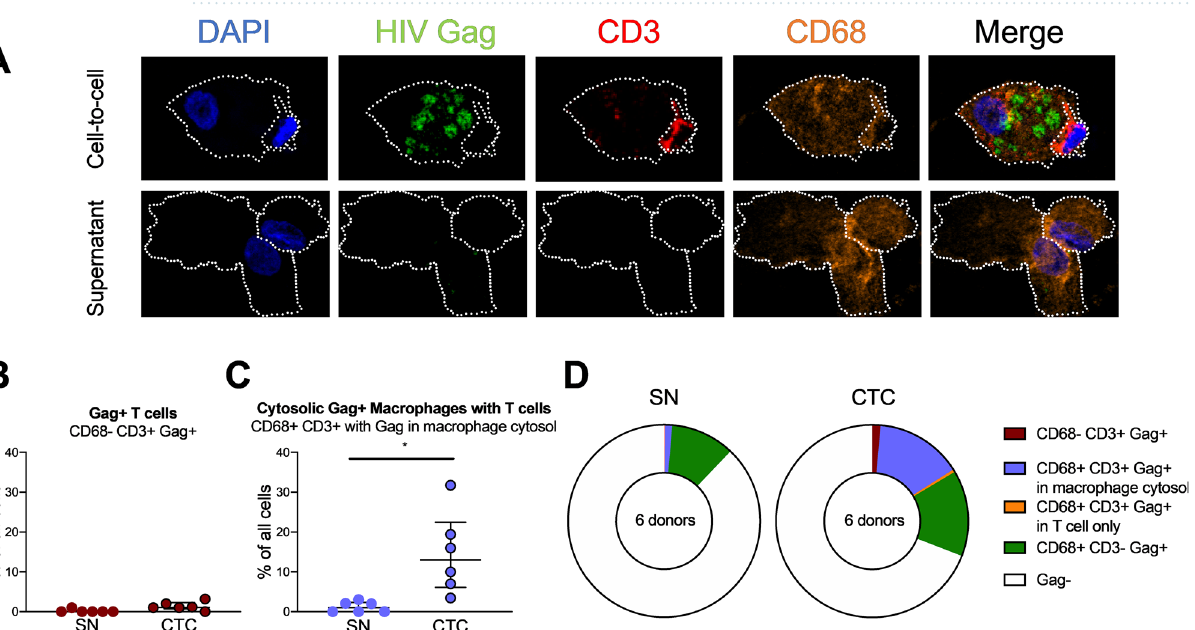
Figure 5. T-tropic HIV-infected T cell contact with AMs leads to HIV Gag staining in the AM cytosol. ( A ) AMs were co-cultured with HIV JR-CSF-infected autologous CD4+ T cells (cell-to-cell, CTC) or T cell supernatant (SN) for 3 h, washed, and cultured for an additional 14 days. Staining was performed with DAPI for cell nuclei, HIV Gag, CD3 for T cells, and CD68 for macrophages, and images were acquired by immunofluorescent confocal microscopy. White dotted outlines show the AM or T cell membrane. ( B – D ) % Gag+ cells out of all nucleated cells were quantified. ( B ) Gag + CD4+ T cells not associated with AMs (Gag+ T cells) were rare in both the SN and CTC conditions. ( C ) Cytosolic gag staining was increased in AMs associated with CD3+ T cells in the CTC condition compared to the SN condition. ( D ) Pie charts of all of the staining categories in SN and CTC conditions. Gag staining was rarely observed in solitary CD3+ T cells. Each category was compared between SN and CTC by the Friedman test with Dunn’s multiple comparison’s test. 100 cells per donor were quantified; n = 6 donors. * p <